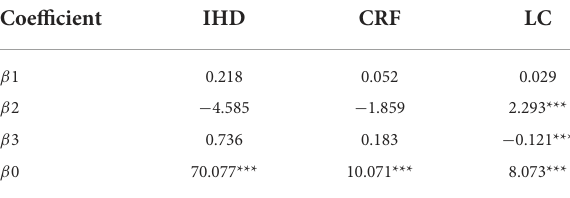
TABLE 4 The impact on the number of inpatient admissions (ITS